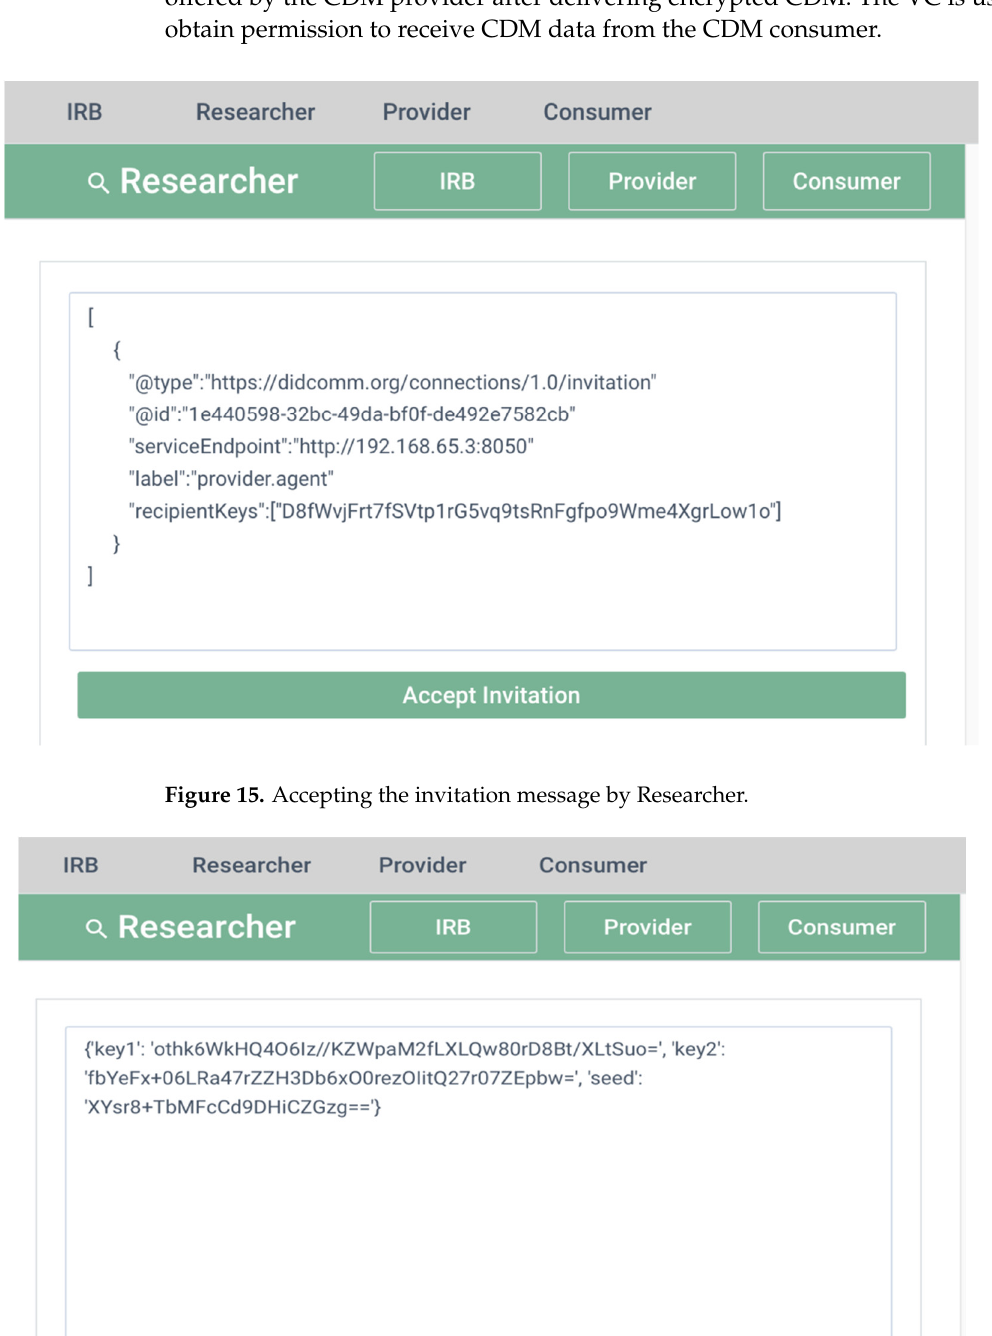
Figure 16. VC offered by the CDM provider after delivering CDM encrypted.